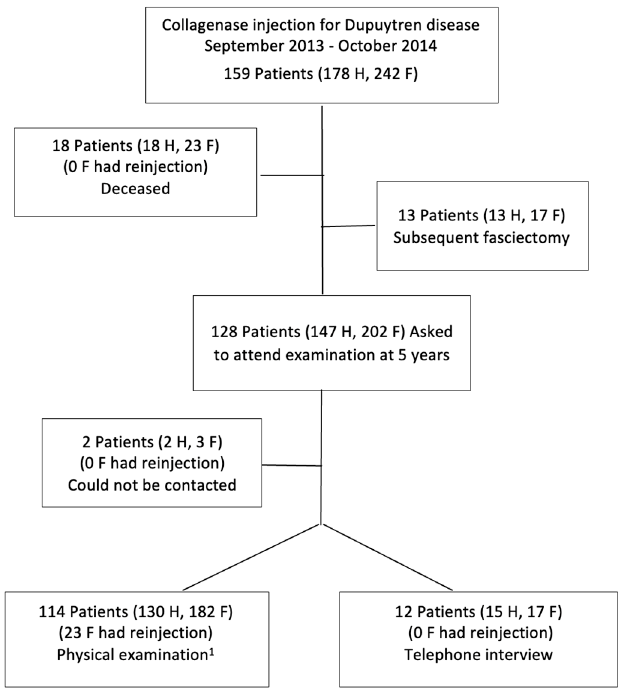
Figure 1. Flow chart of patients. 1 Follow-up time was 54–59 months for 8 patients. F, fingers; H, hands.